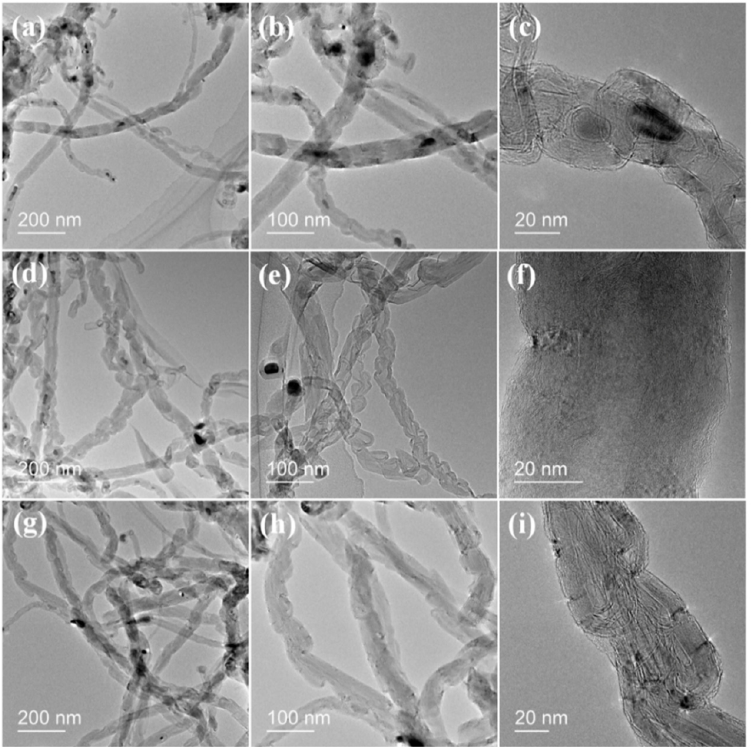
Figure 8. TEM images of CNCs formed with ( a – c ) Ni/ α –Al 2 O 3 , ( d – f ) NiCo/ α –Al 2 O 3 , and ( g – i ) Co/ α –Al 2 O 3 catalyst at 900 °C.